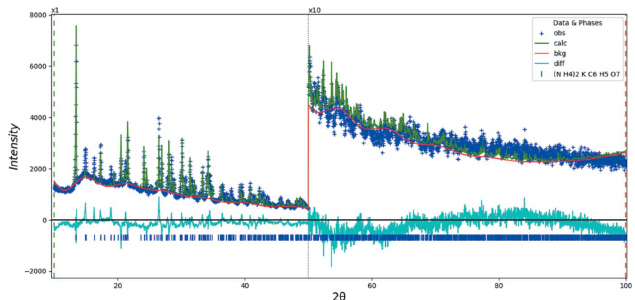
Figure 6 Rietveld plot for (NH 4 ) 2 KC 6 H 5 O 7 . The blue crosses represent the observed data points, and the green line is the calculated pattern. The cyan curve is the normalized error plot. The vertical scale has been multiplied by a factor of 10 (cid:7) for 2 (cid:2) > 50.0 (cid:5) . The row of blue tick marks indicates the calculated reflection positions. The red line is the background curve.